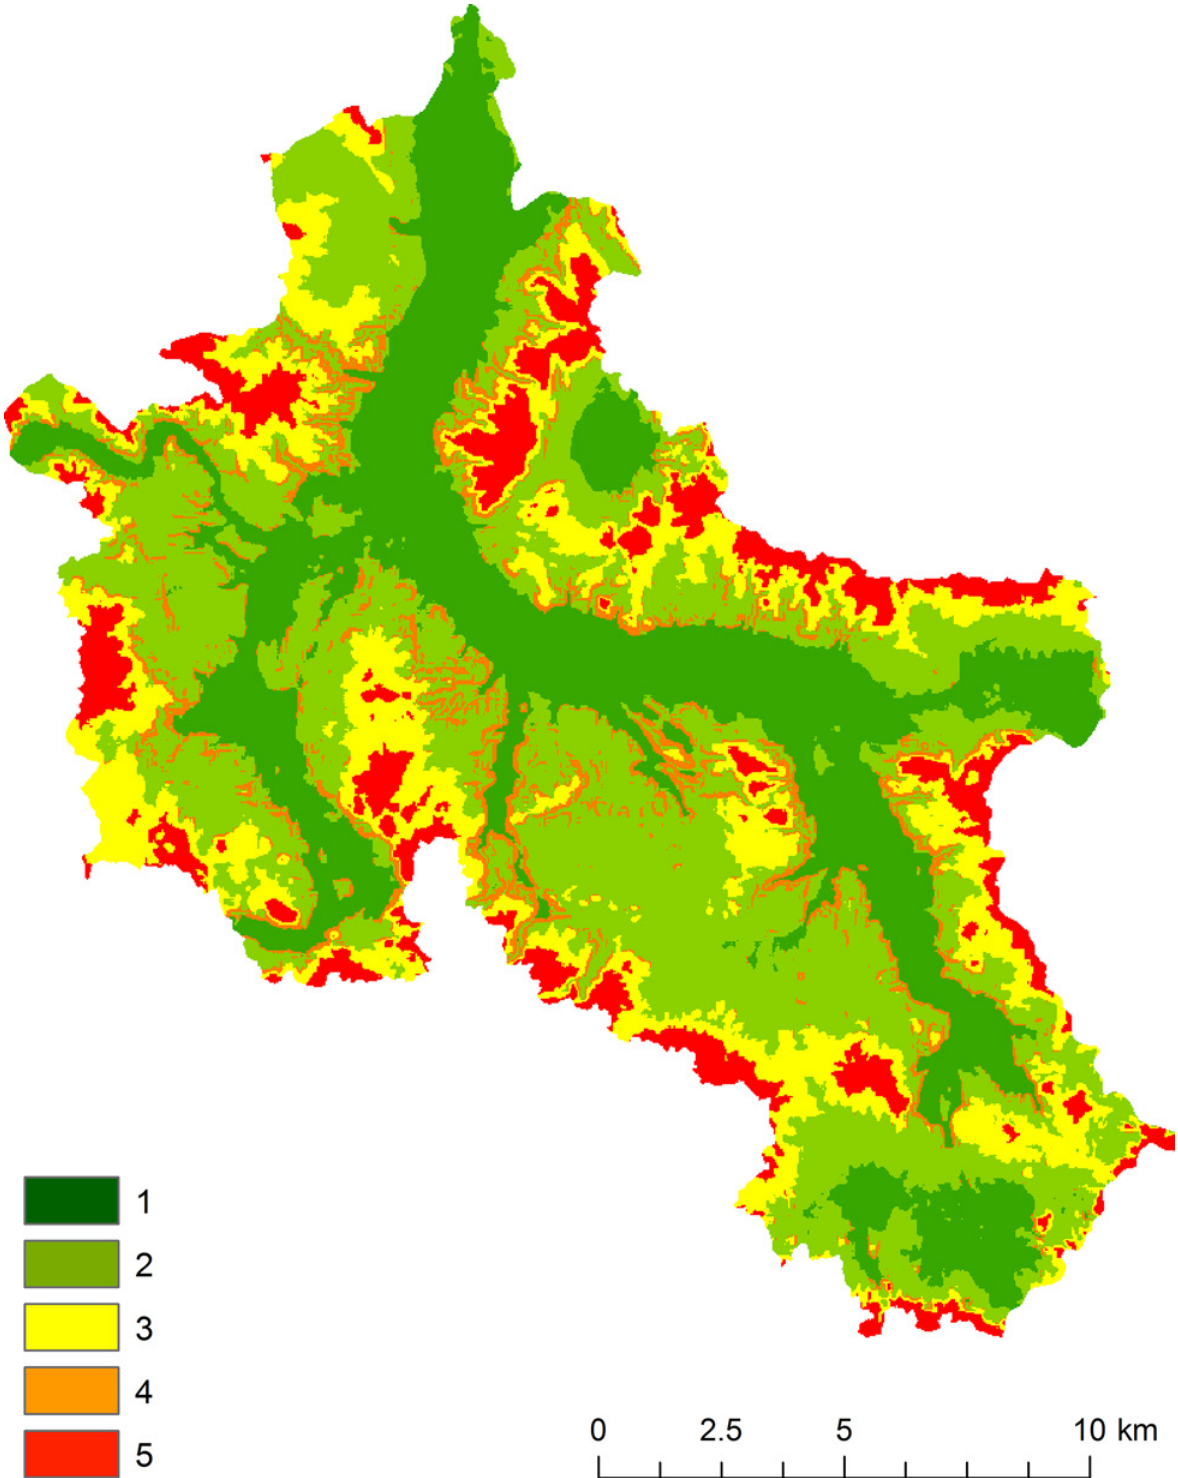
Fig. 5. Factor map of the landform fragmentation